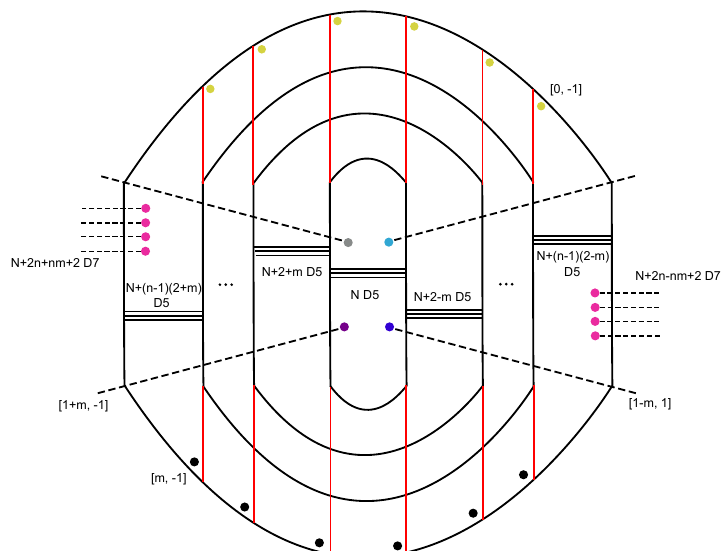
Figure 26 . The schematic diagram after moving the branch cuts of B ; C and X 7-branes from (cid:12)gure 24. The red lines arise from D5-branes which cross the branch cuts of B ; C X and X 7-branes. The [0 ; 1] 7-branes denoted by the yellow circles in the upper [1+ m; 1] [1 m; 1] (cid:0) (cid:0) part of the diagram arise from D7-branes which cross the branch cuts of B ; C 7-branes. On the other hand, the [ m; 1] 7-branes denoted by the black circles in the lower part of the diagram arise (cid:0) from D7-branes which cross the branch cuts of X